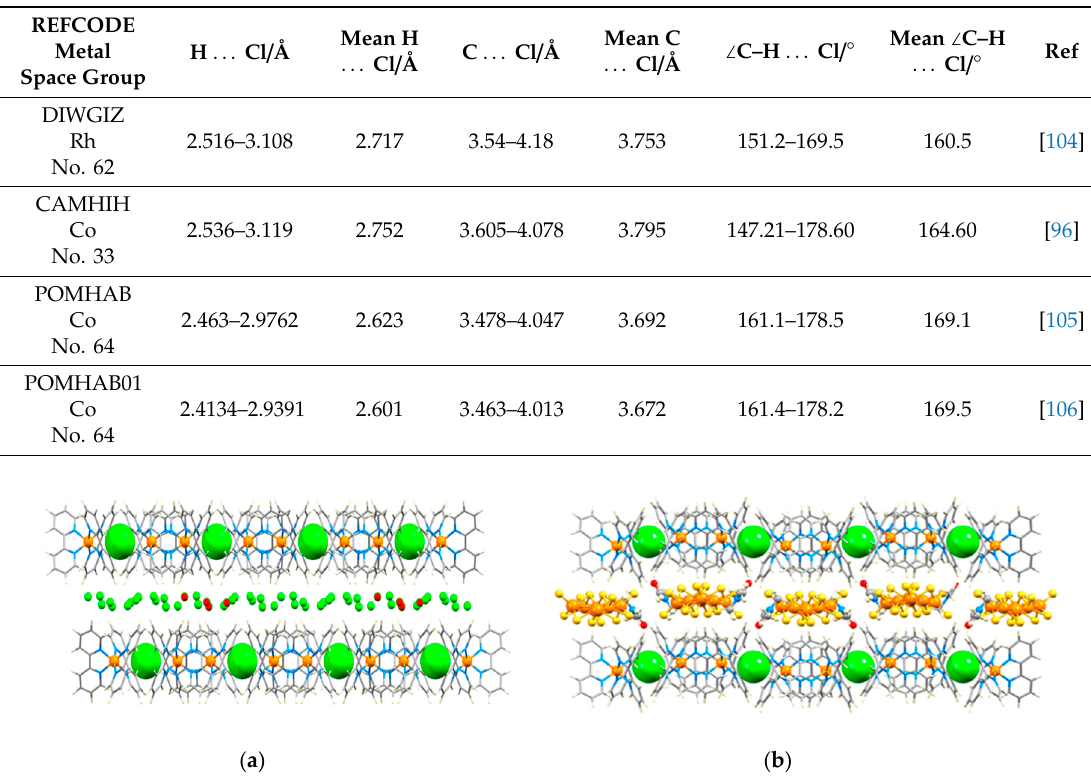
Table 3. Structure Type 1 sub-motifs with three cations interacting with chloride.